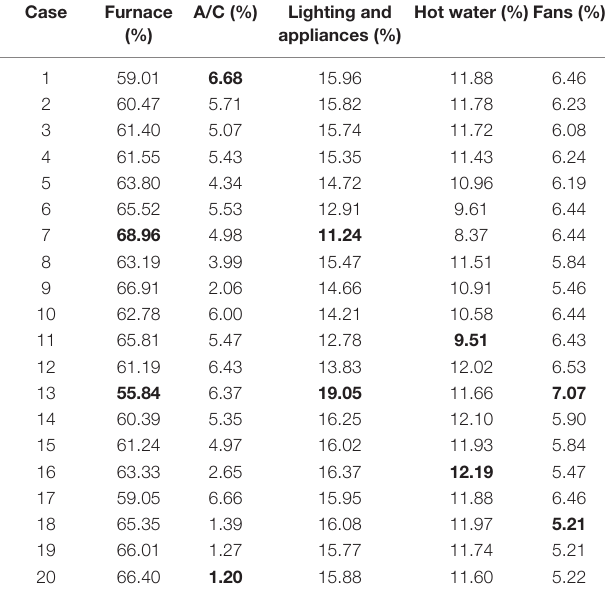
Bold font indicates the highest and lowest percentages in energy